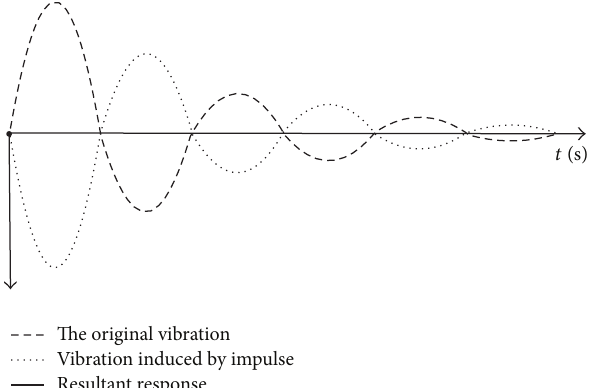
Figure 5: The principle of